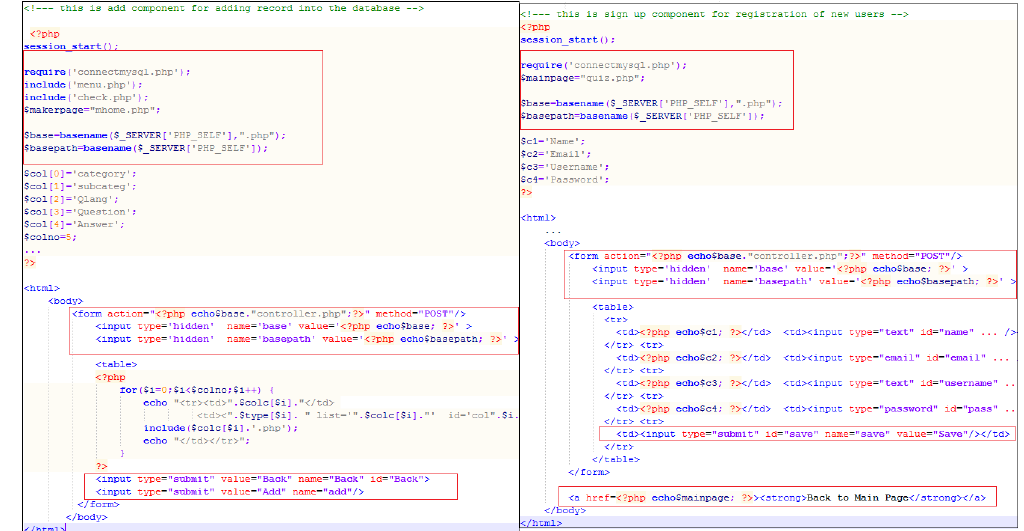
Figure 9. Sample code templates for sign up and add components.